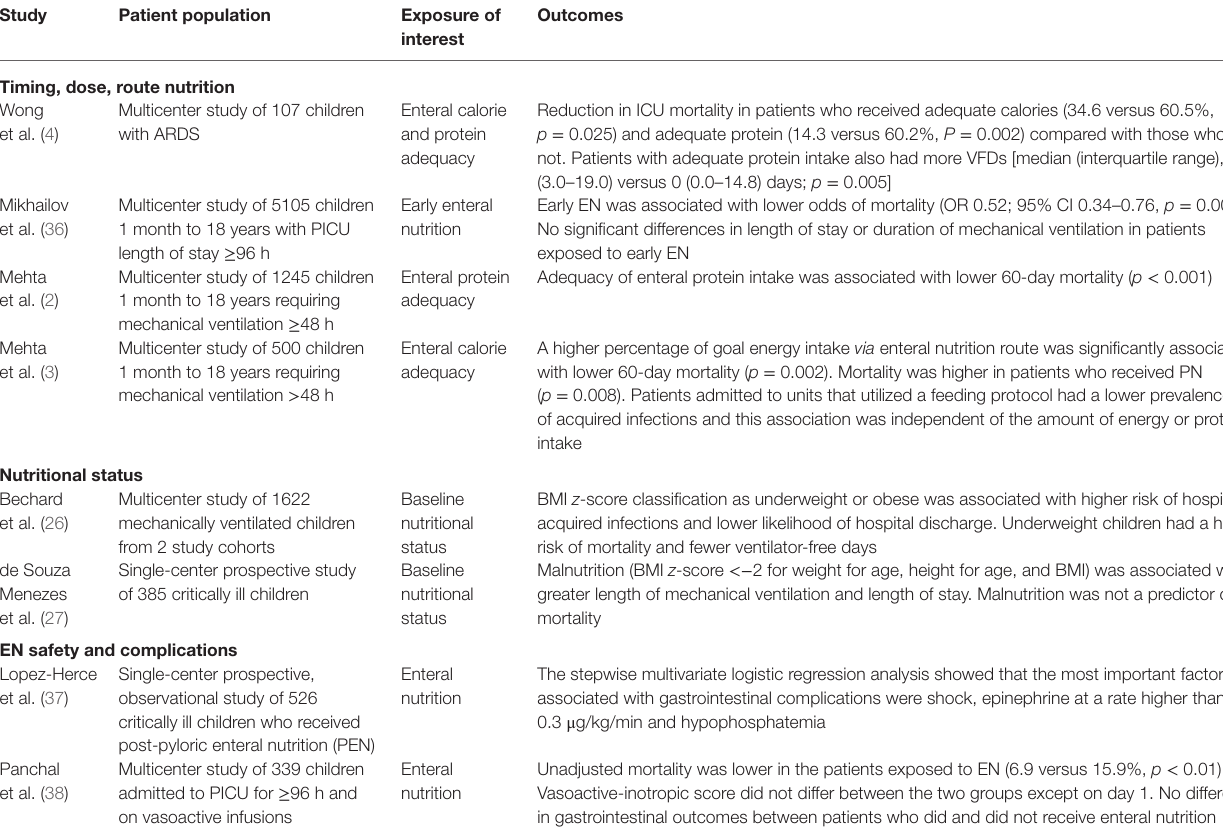
TABLe 1 | Key observational studies of the impact of nutrition and nutritional status on patient outcomes in pediatric critical